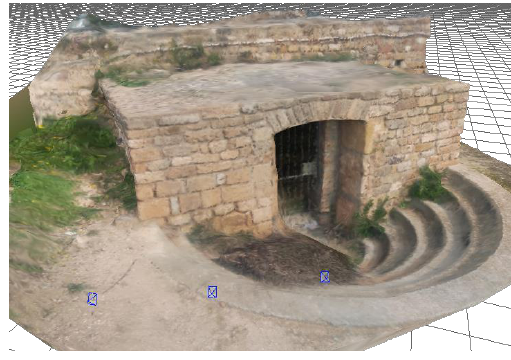
Figure 9- Photomodeling of a house in the site museum of Carthage using Zephyr